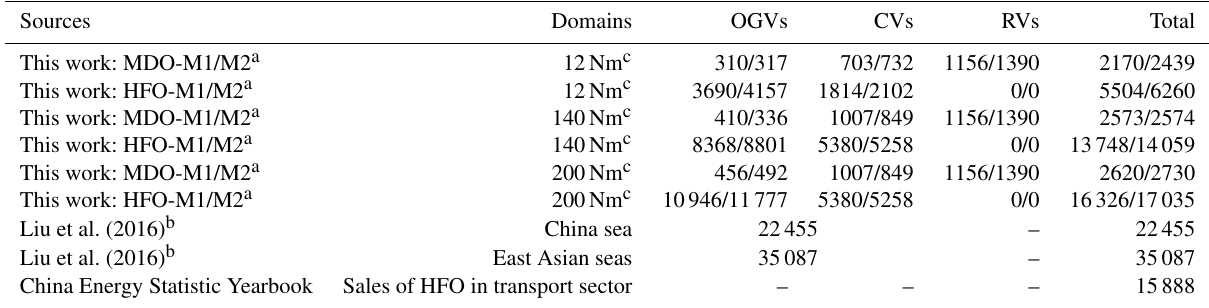
Table 6. Comparison of HFO consumption in China in 2013 (unit: kt). Sources